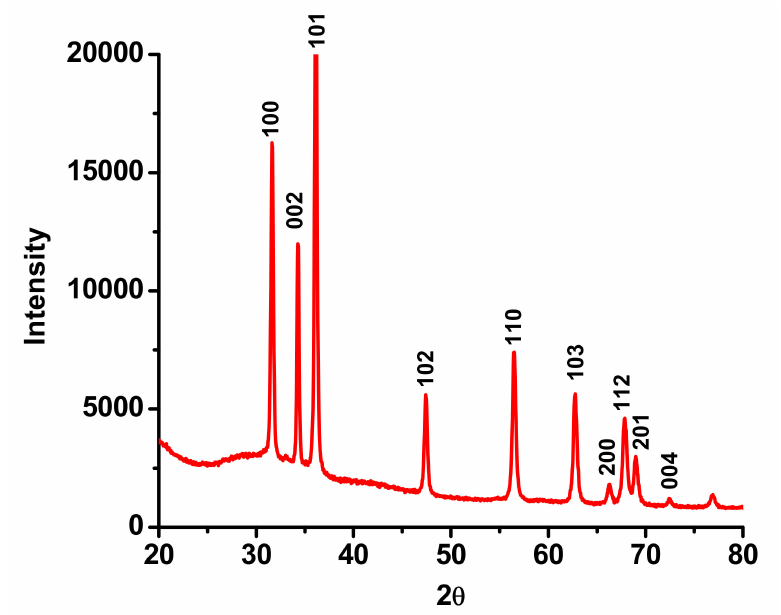
Figure 5. XRD diffraction pattern of as-synthesized